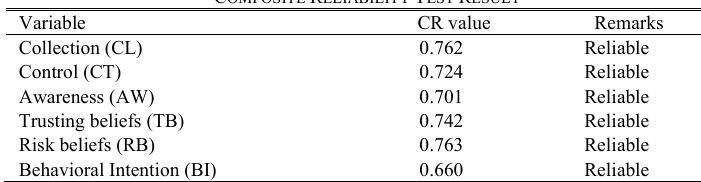
TABLE 7 C OMPOSITE R ELIABILITY T EST R